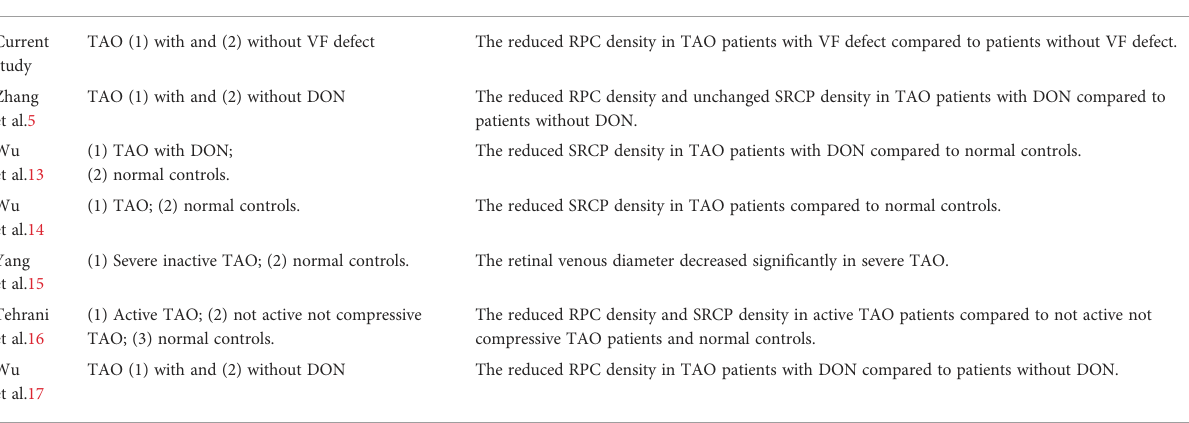
TABLE 5 Summary of previous studies on retinal perfusion changes in